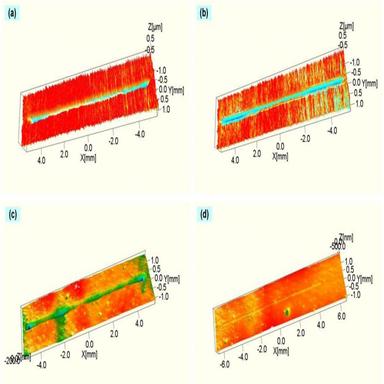
Representative 3D-topography of wear tracks under different surface status (a) conventional surface (dry friction) (b) conventional surface (lubrication) (c) ultra-smooth surface (dry friction) (d) ultra-smooth surface (lubrication).